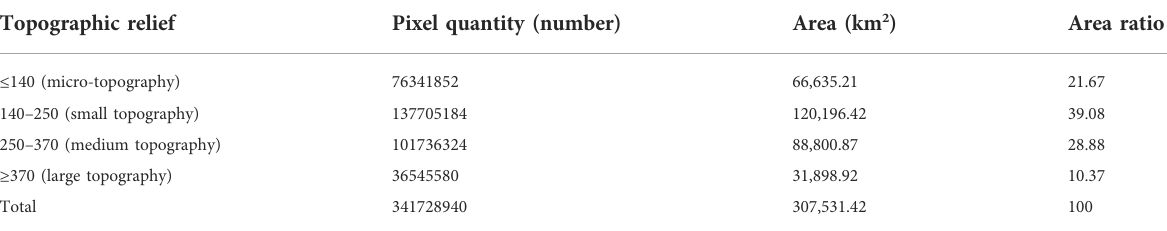
TABLE 1 Statistical results of topographic relief in Qinba Mountains.